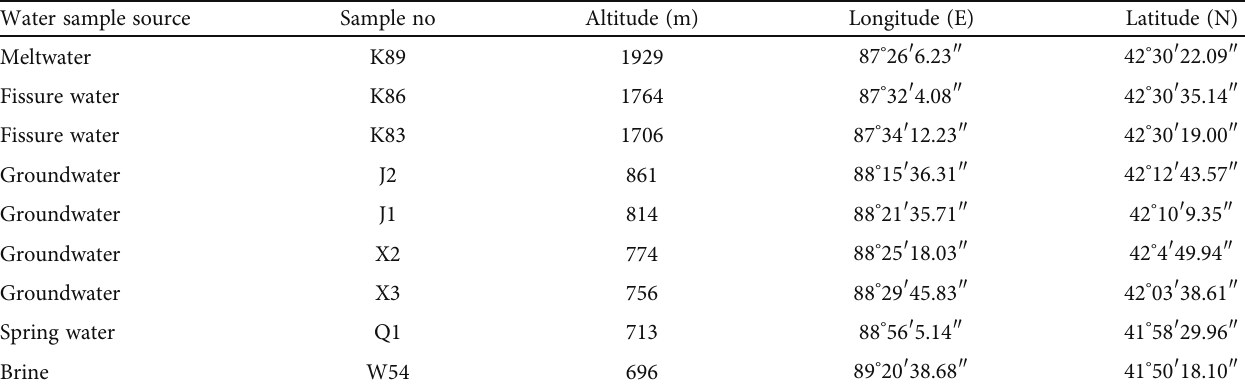
Table 1: Geographical locations of water sampling sites and water sample sources.